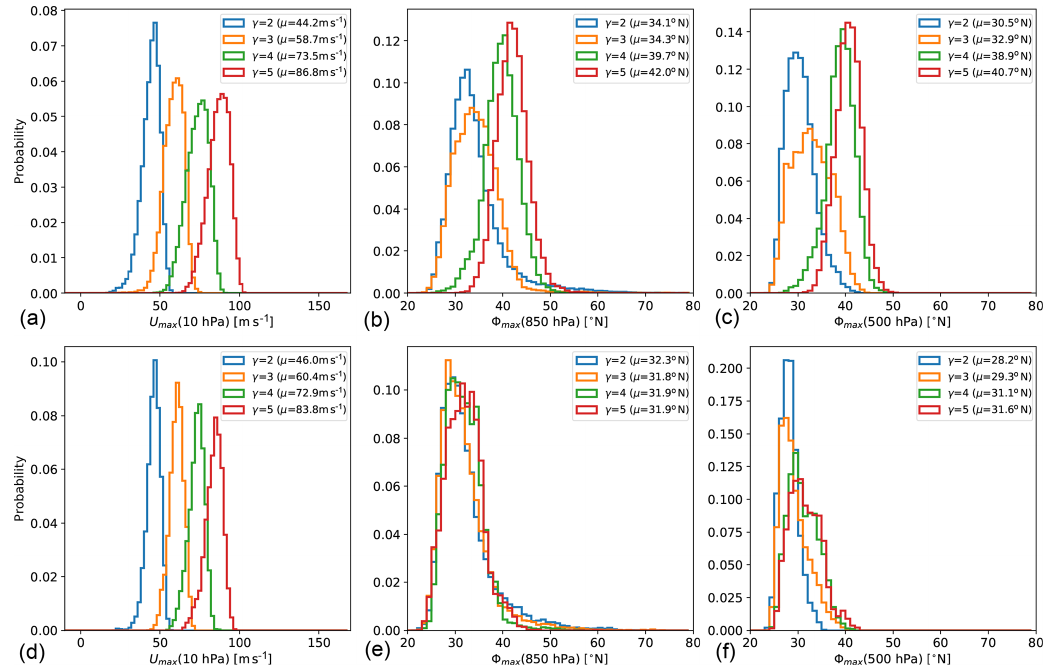
Figure C1. Probability distributions of (a, d) the maximal zonal-mean zonal wind at 10hPa, (b, e) the latitude of the maximum of zonal-mean zonal winds at 850hPa, and (c, f) at 500hPa for simulations without planetary wave forcing, with (a, b, c) for the original PK02 setup and (d, e, f) for the modified setup with reduced δ z . The mean value of the distribution is given in the legend (denoted as µ